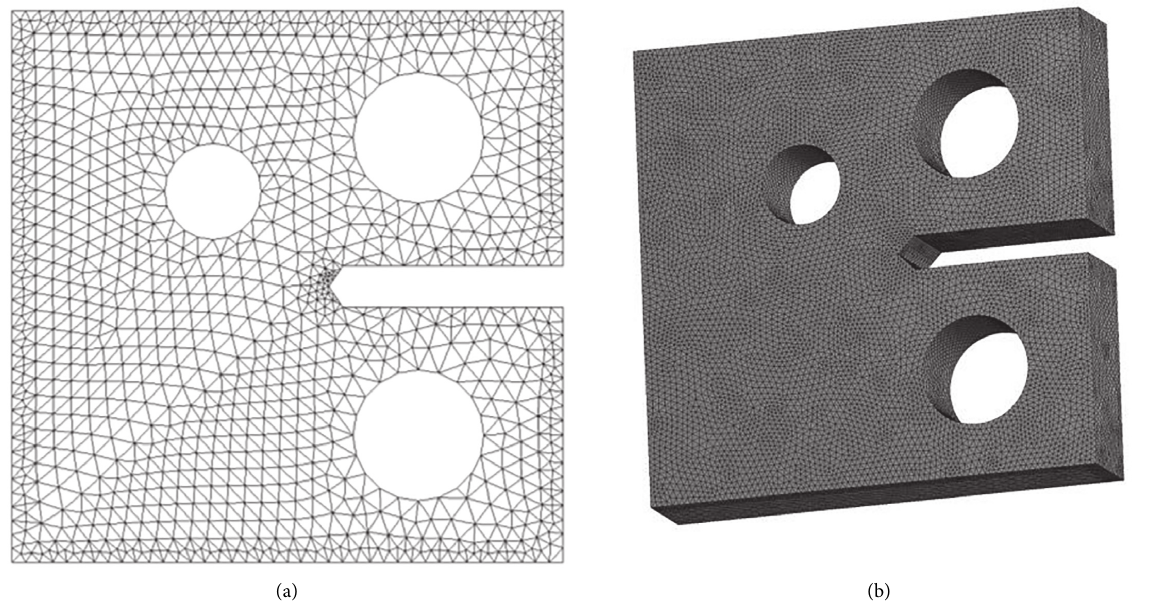
Figure 4: Initial meshes of CT01. (a) FRANC2D/L and (b) ANSYS Mechanical